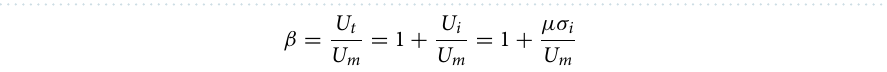
Figure 14. Displacement distribution of the 11th arch on the east